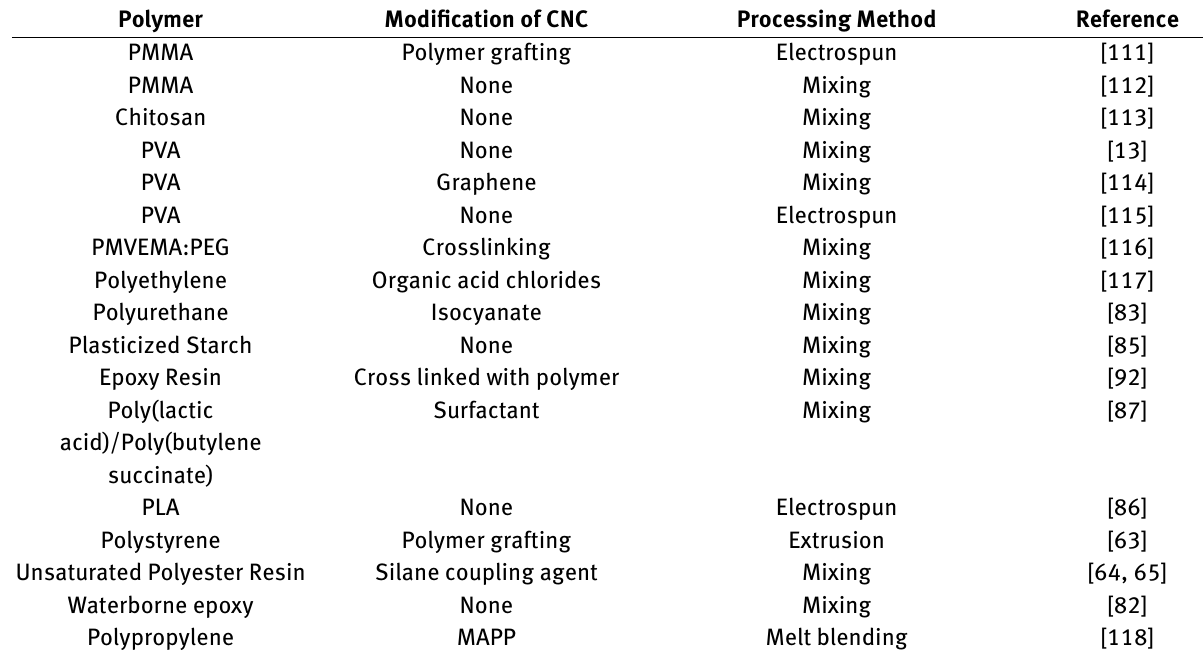
Table 2: List of CNC based composite materials.